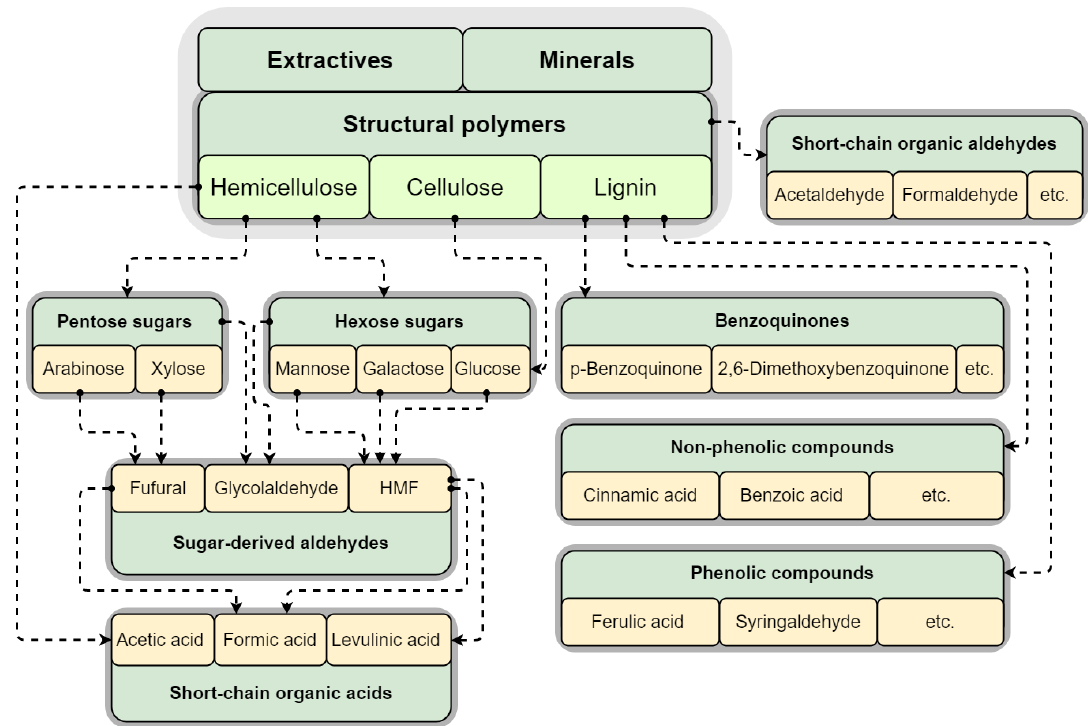
Figure 1. Origins of lignocellulosic inhibitors.